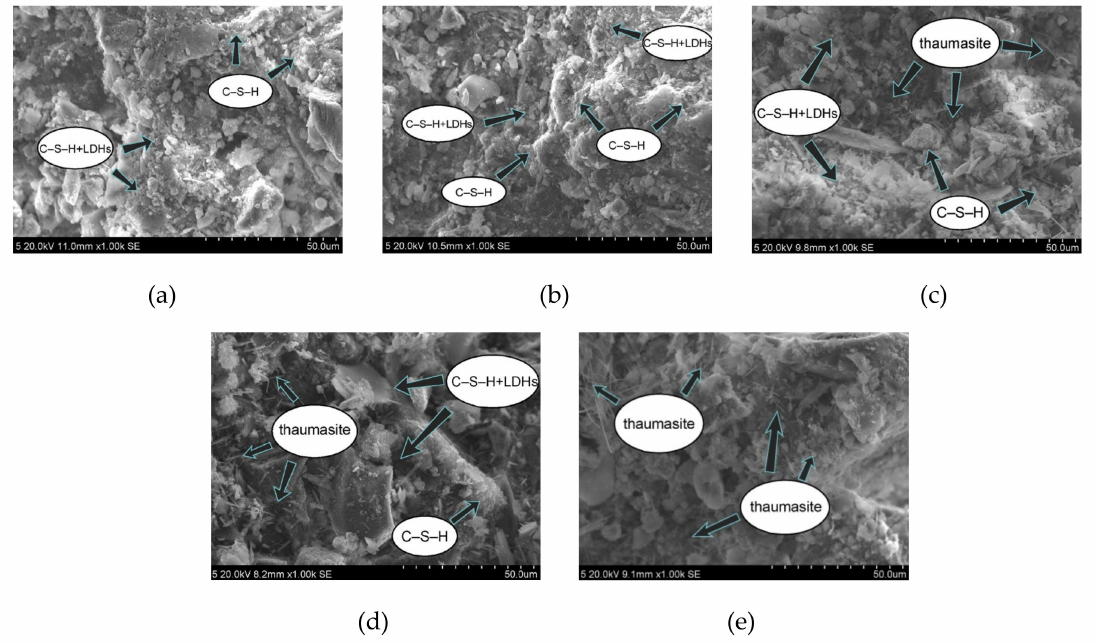
Figure 4. Micromorphology of cemented paste backfill (CPB) samples at 28 days: ( a ) SF0; ( b ) SF5; ( c ) SF10; ( d ) SF15; and ( e )